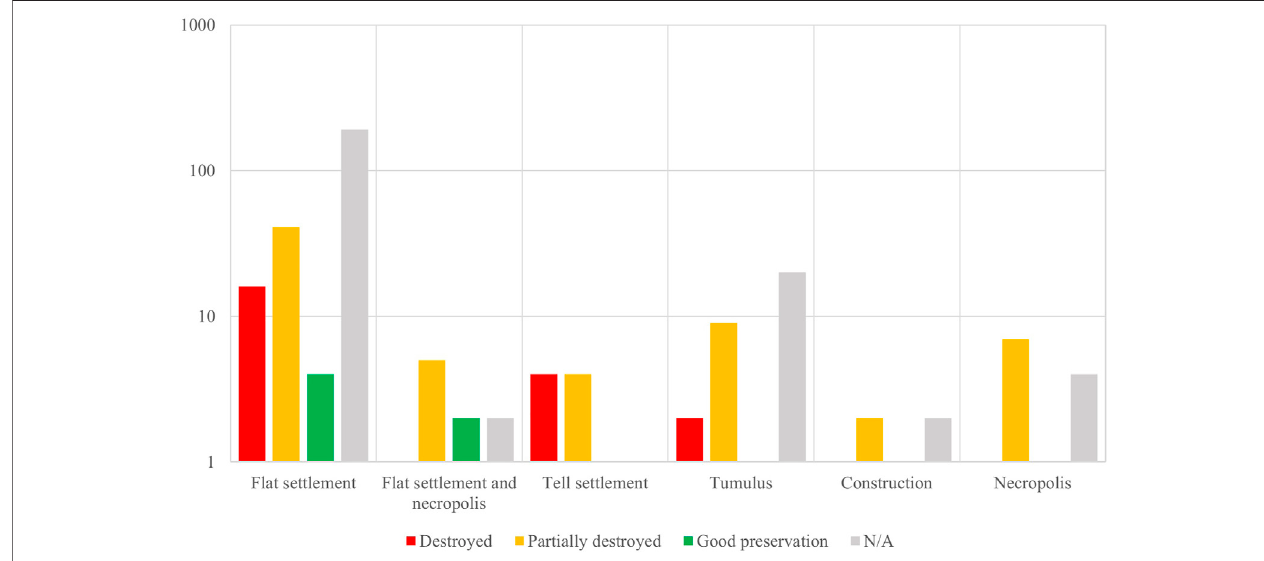
FIGURE 10 | Conservation status distribution of sites by site type.